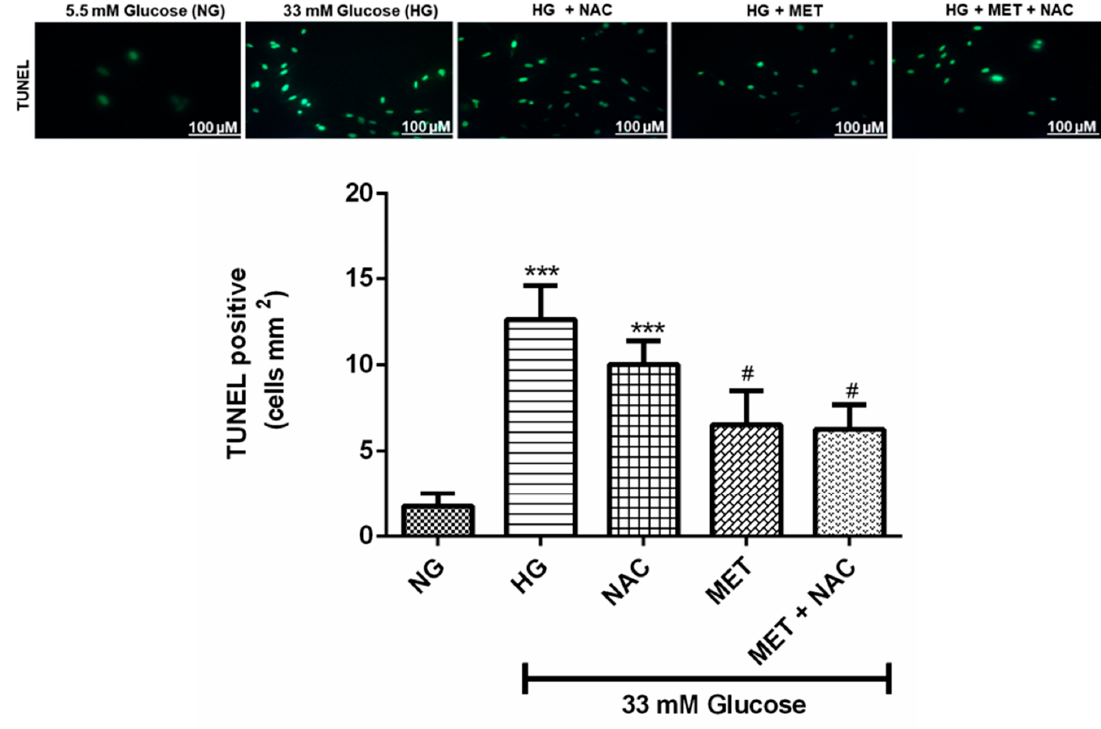
Figure 8. The combination effect of Metformin (MET) and N-acetylcysteine (NAC) on high glucose-induced DNA fragmentation. (A) Photograph microscopy analysis of Tunel positive cells as observed with green fluorescence. (B) Bar graph analysis. H9c2 cardiomyoblasts were cultured in high glucose (HG; 33 mM) for 24 h. Cells were then treated with NAC (1 mM), metformin (MET) (1 µ M) and a combination of MET + NAC. Cells treated with normal glucose (NG) served as the vehicle control. Data presented are expressed as the mean ± SEM of 3 separate biological experiments with each experiment having 3 technical repeats ( n = 9). Significance is depicted as *** p ≤ 0.001 versus NG control, # p < 0.05 ## p ≤ 0.01 versus HG control.